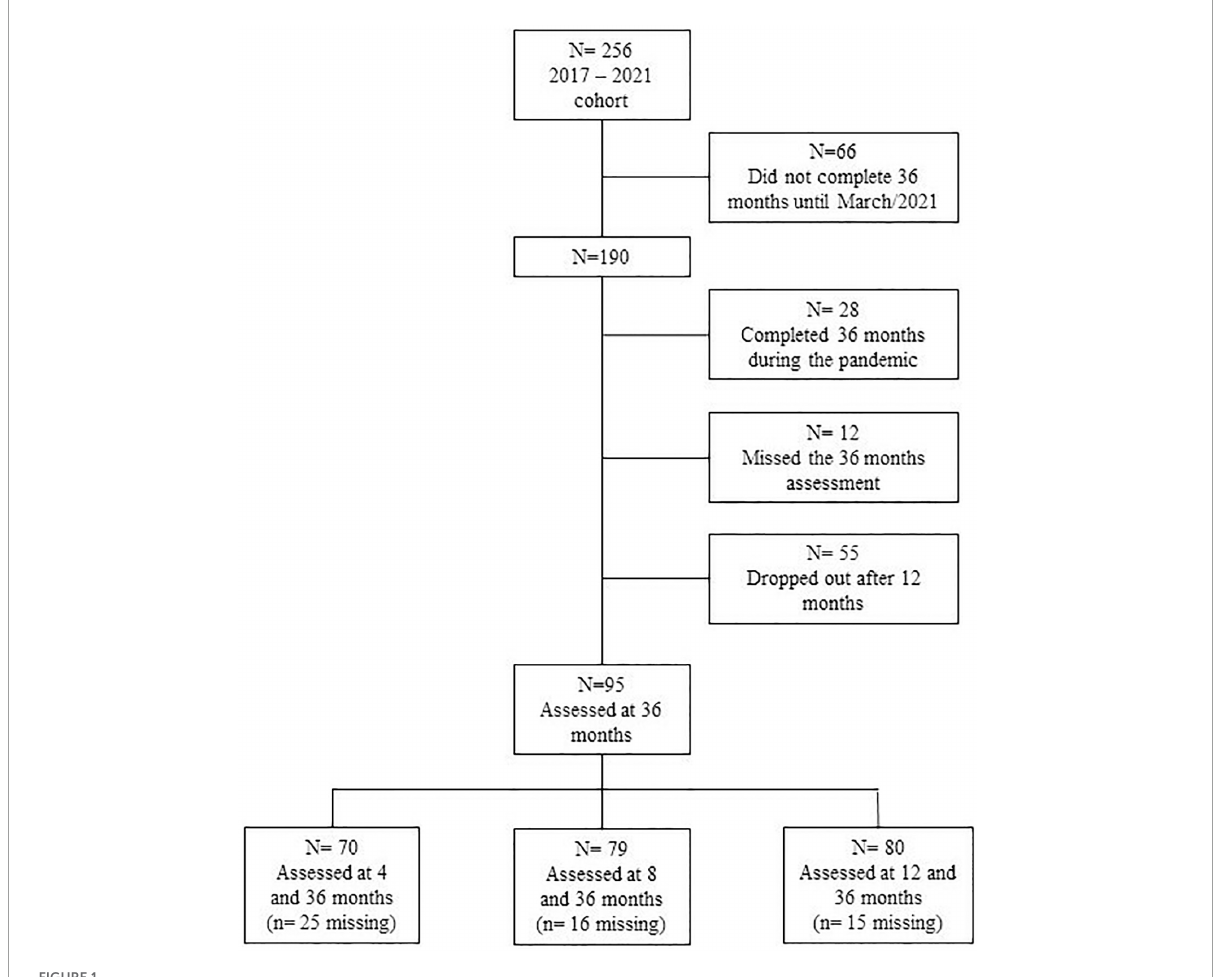
FIGURE1 Participants enrollment in the